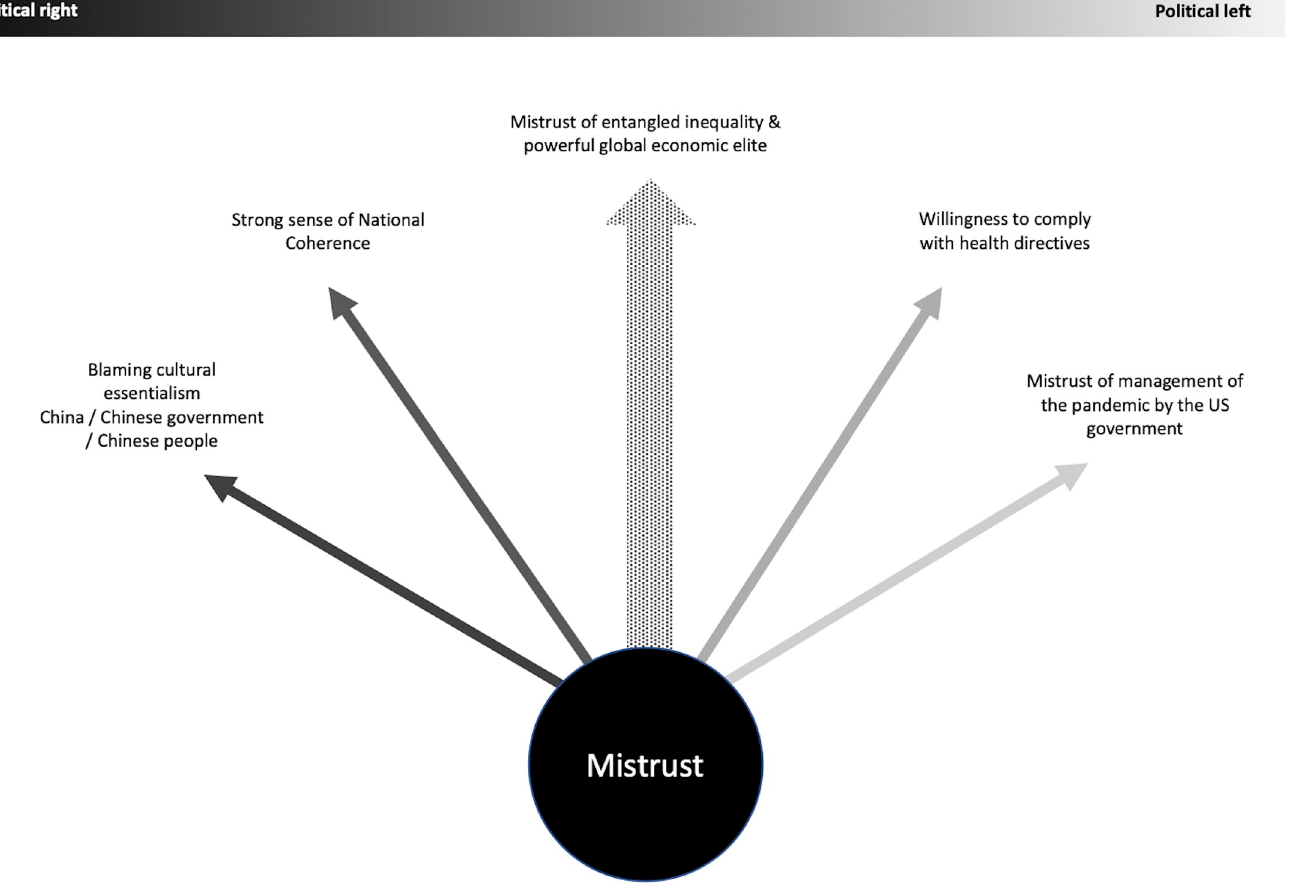
Fig 2. Confluence and